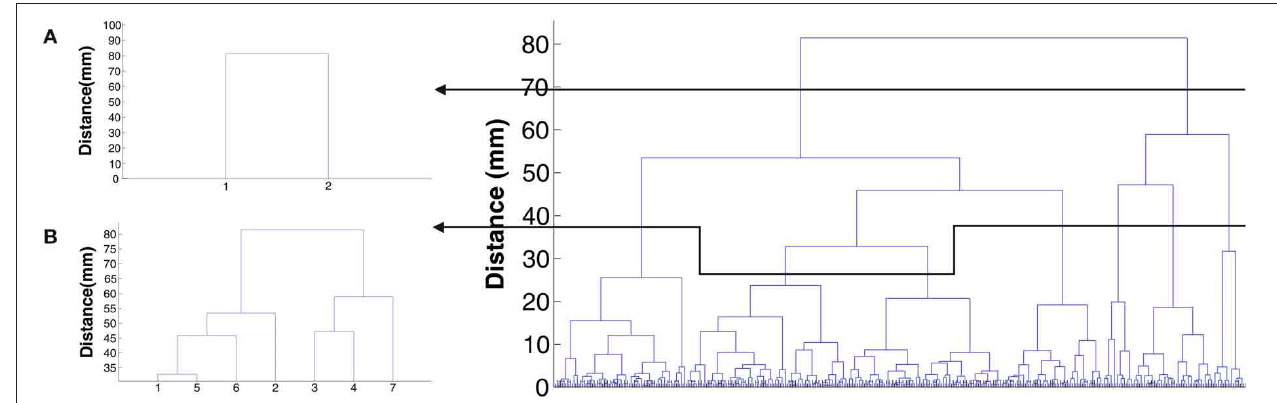
FIGURE 7 | Cluster tree for the cluster in Figure 6A. (A) The cut that leads to Figure 6B . (B) The cut that leads to Figure 6C